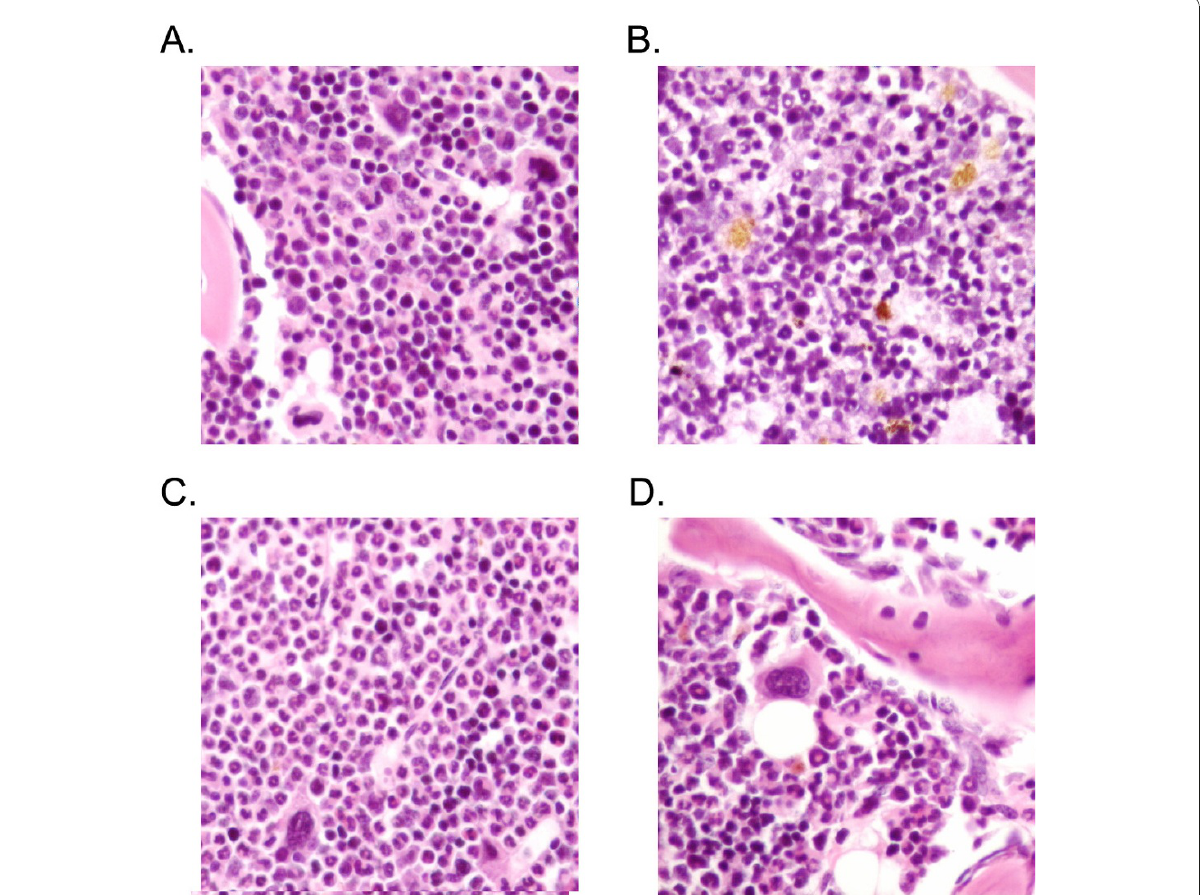
Figure 5 Effects of APS on bone marrow histology . The Wright-Giemsa stained bone marrow sections were examined for Normal (A), Control (B), APS treated (C) and TPO treated (D)